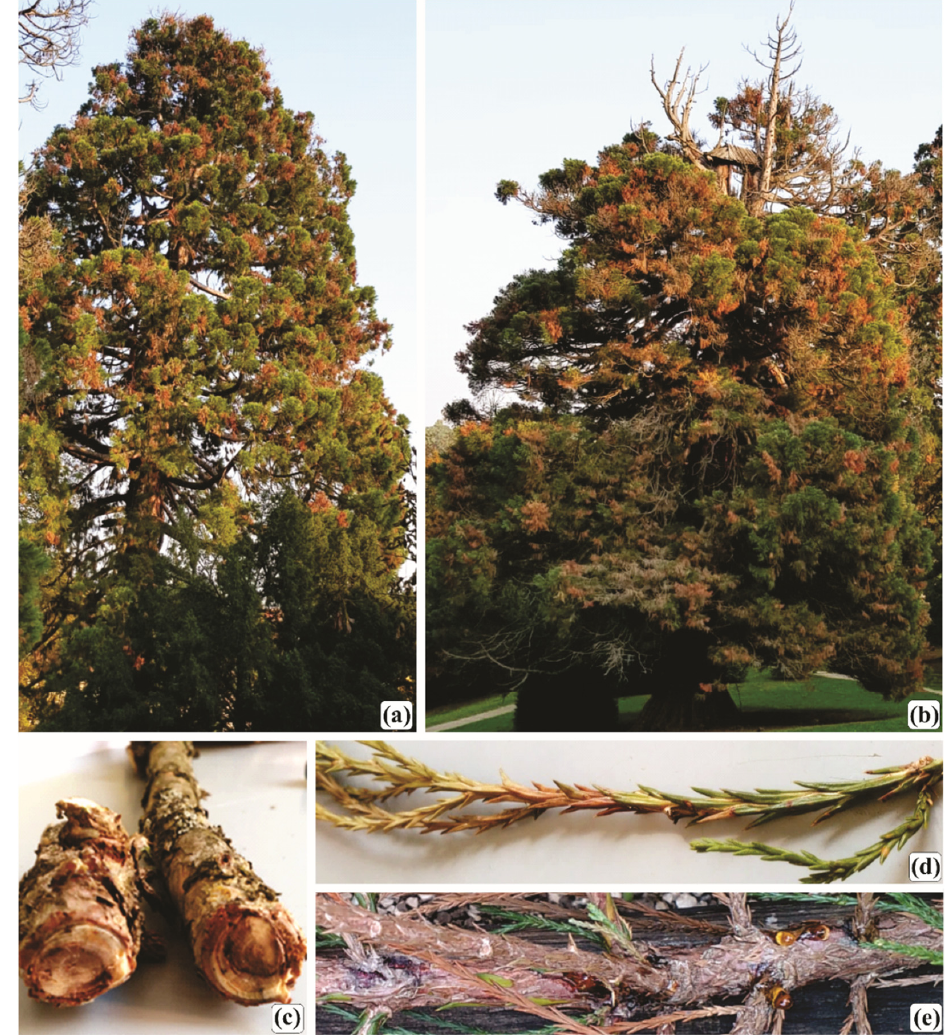
Figure 1. Disease symptoms observed on Sequoiadendron giganteum Lindl. [Buchholz] trees in Zagreb, Croatia. ( a ). Scattered branch die-back. ( b ). Top die-back and scattered branch die-back. ( c , e ). Resinous branch canker ( d ). Needle die-back.